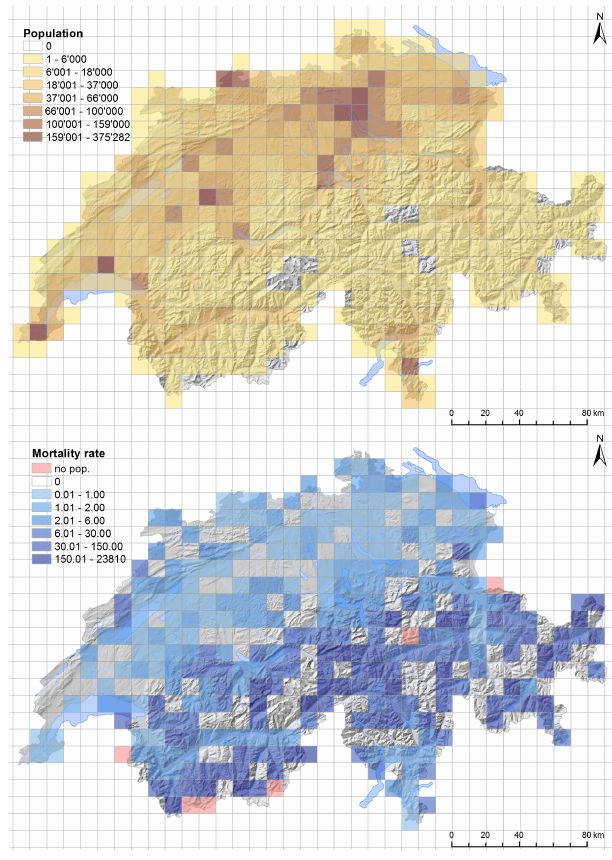
Figure 10. Spatial distribution of the population as of 2015 (above) and normalised natural hazard fatalities per year and million pop- ulation (below) in Switzerland over the 70-year study period using a 10 × 10km raster grid (DHM source: dhm25 © 2016 swisstopo, 5704 000 000). Note that the gridded mortality rate (below) rep- resents a rough estimate because the population data of 2015 were used for its calculation (prior data not available in this format). Also, note that no mortality rate was calculated for the red grid cells be- cause they are not populated (even though fatalities occurred there).